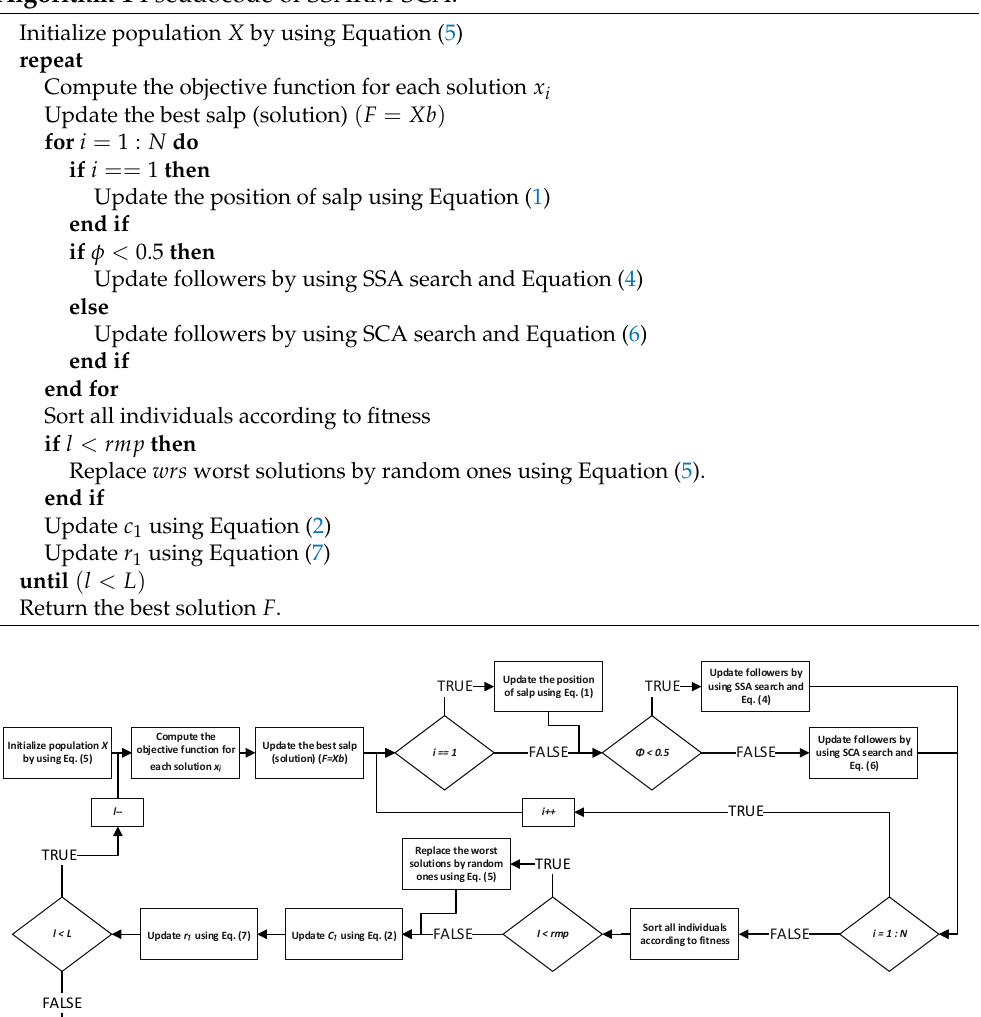
Algorithm 1 Pseudocode of SSARM-SCA.